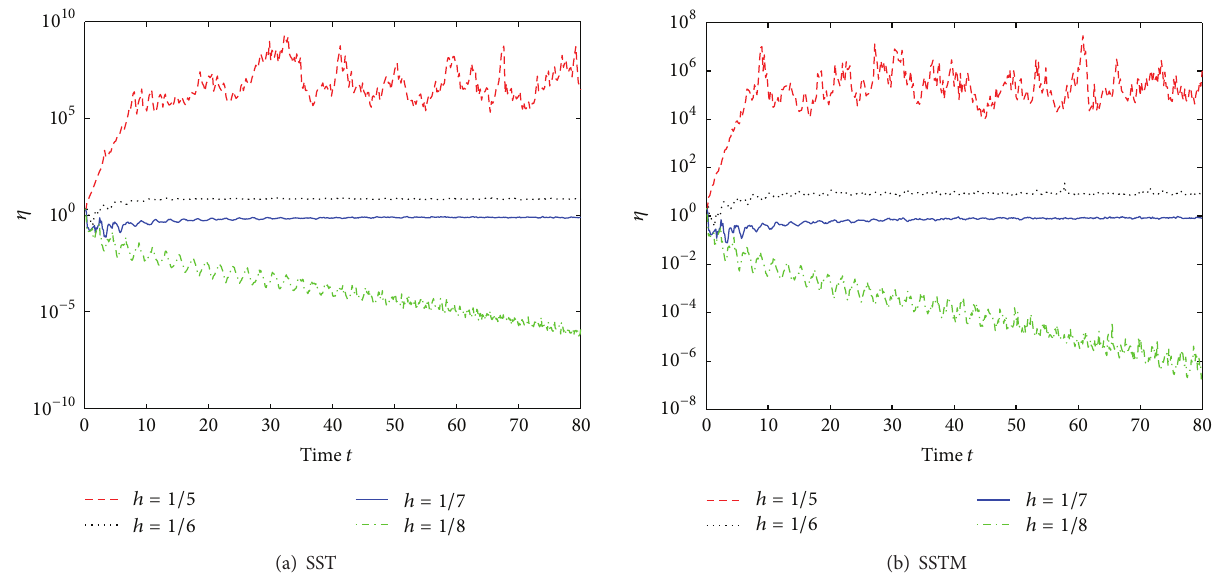
Figure 3: Mean-square stability comparison of SST and SSTM for the SDHNNs (43), Case 2, 𝜃 = 0